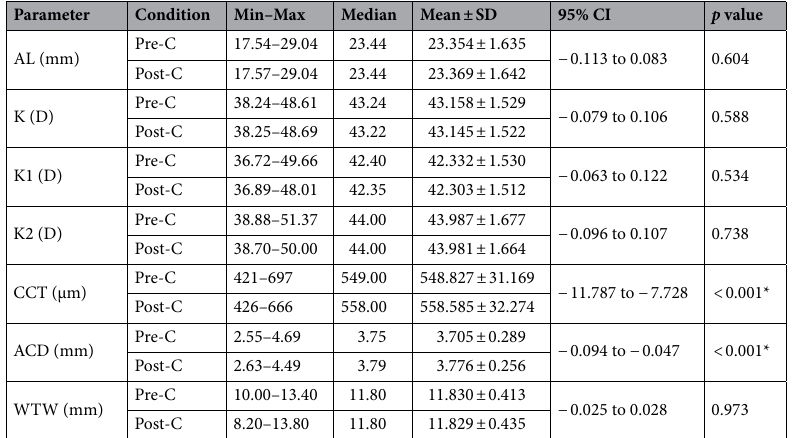
Table 1. Statistical analysis of the mean, SD, and 95% CI of ocular biological characteristics of the subjects pre- and postcycloplegia in all individuals. AL axial length; K mean keratometry, K1 flat keratometry, K2 steep keratometry, CCT central corneal thickness; ACD anterior chamber depth; WTW white-to-white distance; D dioptre; C cycloplegia, SD standard deviation; CI confidence interval. * p < 0.05 was considered statistically